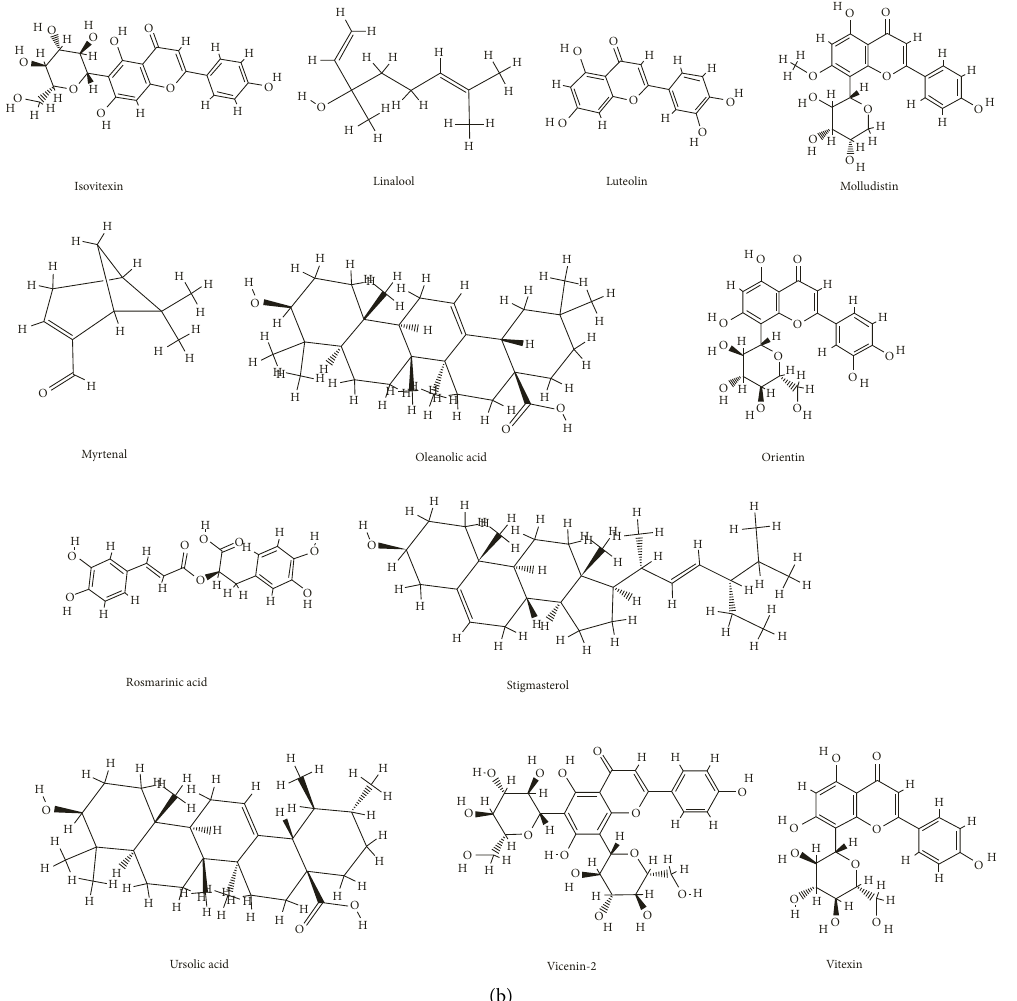
Figure 1: (a) The identified bioactive compounds and the chemical structures in tulsi ( Ocimum sanctum Linn ). (b): The identified bioactive compounds and the chemical structures in Tulsi ( Ocimum sanctum Linn